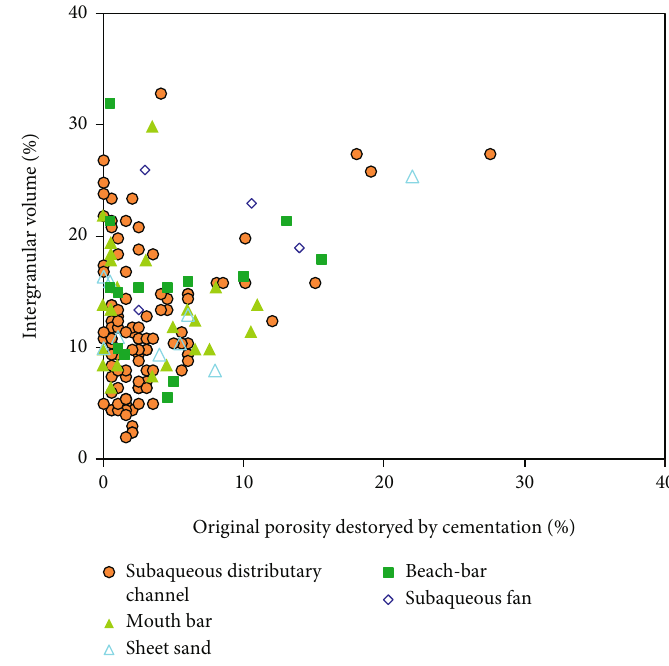
Figure 15: The plot of intergranular volume vs volume content of cements shows the relative importance of compaction and cementation in w sandstones. the porosity reduction of E 2